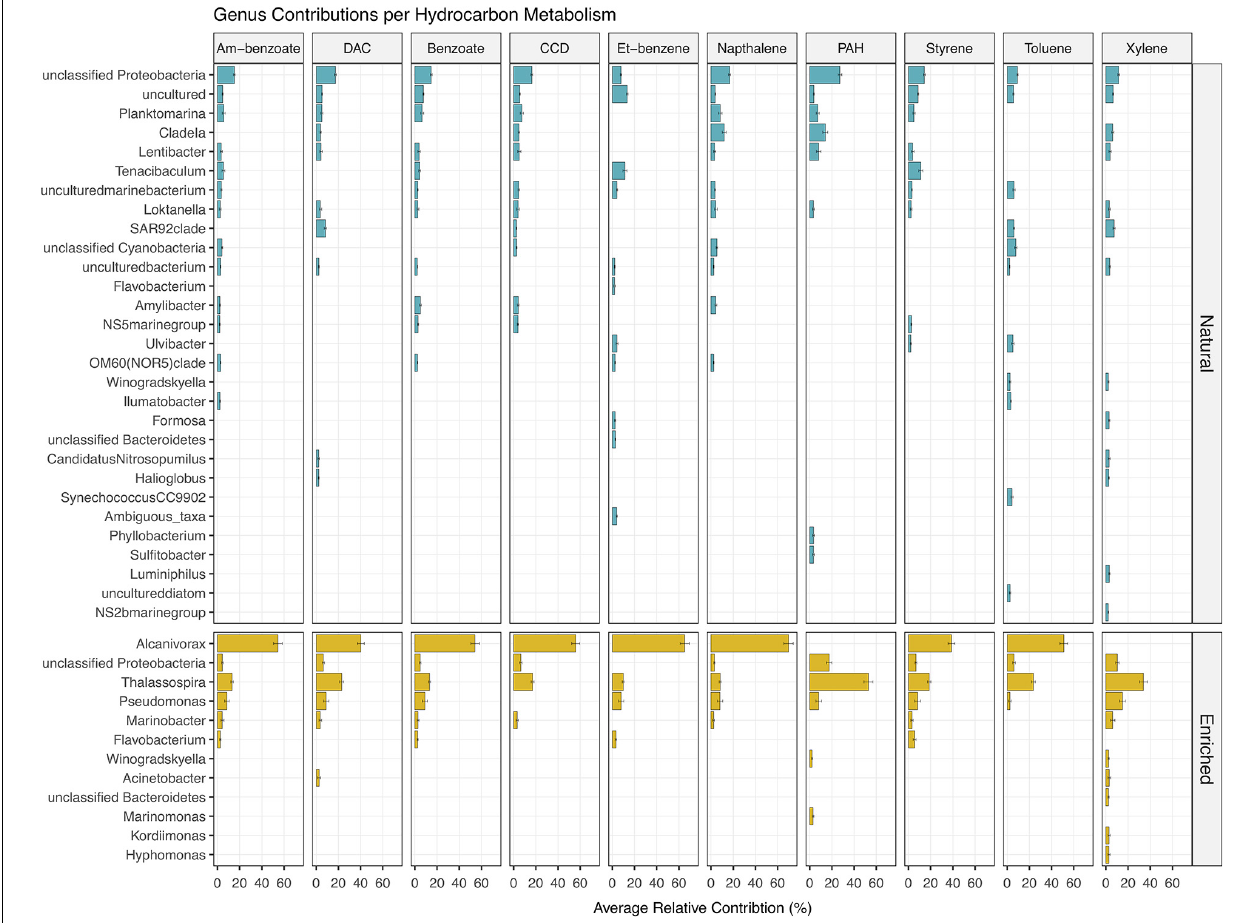
FIGURE 9 | Prediction of the relative contribution (above 2%) of each genus for the 10 aromatic hydrocarbon degradation pathways present in natural and oil-enriched microbial communities. Am-benzoate, Aminobenzoate; DAC, Degradation of Aromatic Compounds; CCD, Chlorocyclohexane and Chlorobenzene Degradation; Et-benzene,